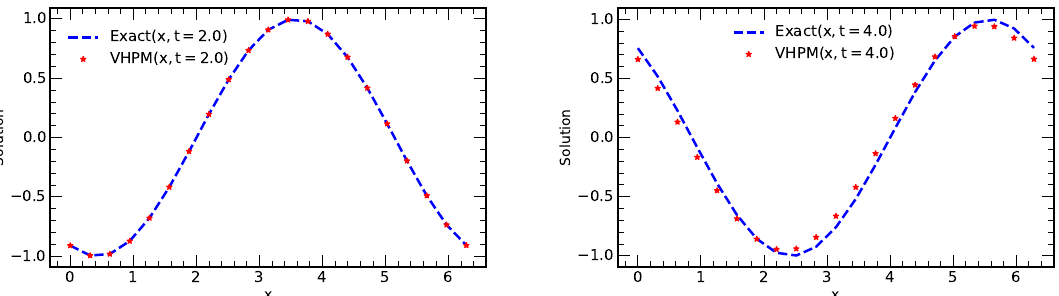
Figure 1. Plots of exact and approximate solutions vs x using n = 10 terms from VHPM at times (cid:0) 0.1, 1.0, 2.0 and 4.0. The spatial step size used is π